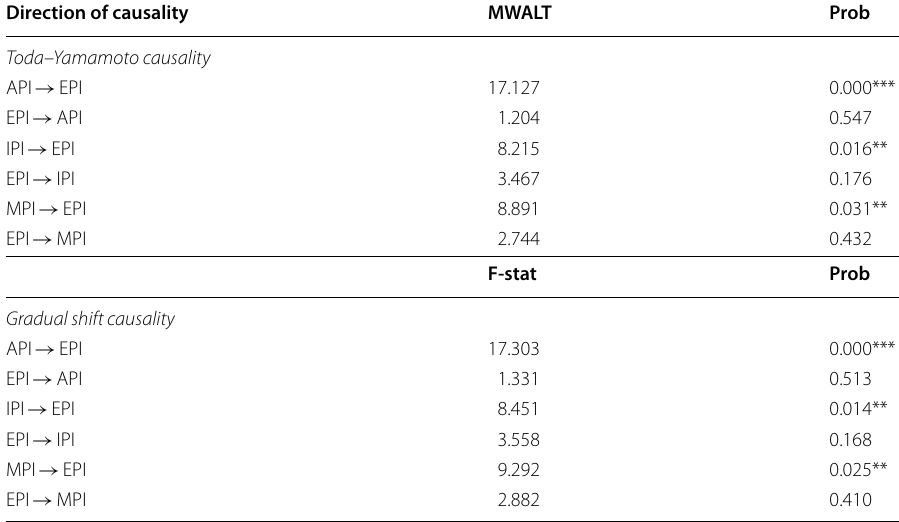
Table 4 Causality